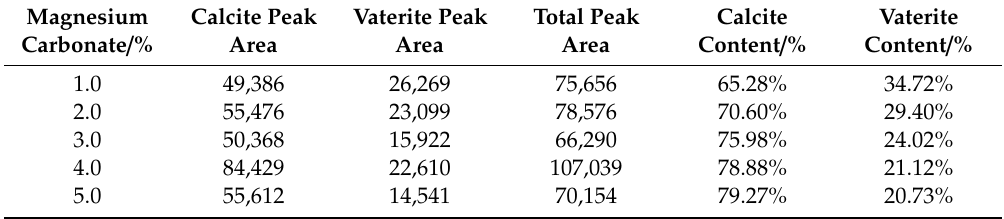
Table 2. The relationship between the content of the di ff erent crystal forms of calcium carbonate and the amount of magnesium carbonate in magnetized anti-scaling